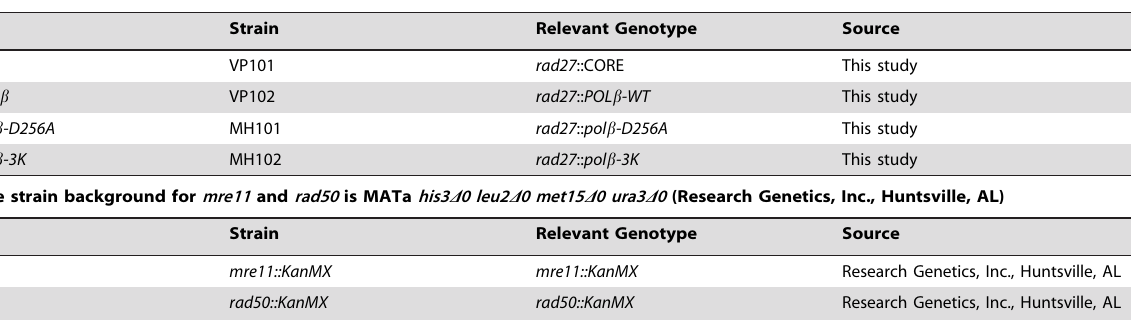
Table 1. S. cerevisiae strains used in this